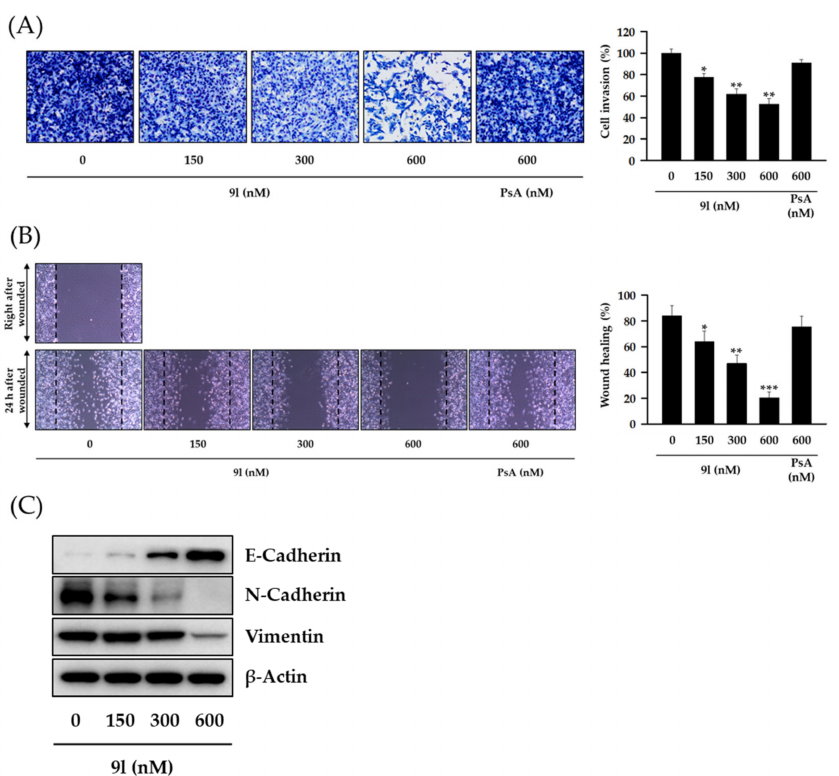
Figure 6. The inhibitory effects of 9l on cell invasion and migration via EMT gene regulation in TNBC cells. ( A ) MDA-MB-231 cells were pretreated with 9l or PsA at the indicated concentrations for 24 h, reseeded into the upper chambers of Transwell inserts, and incubated for 24 h. Cells invading the lower chambers were fixed, stained, imaged ( left ), and counted ( right ). * p < 0.05 and ** p < 0.01 values indicated statistically significant differences relative to the vehicle-treated control group. ( B ) Monolayers of MDA-MB-231 cells were mechanically scratched and treated with 9l or PsA for 24 h. Representative light microscopy images of wound closure are shown ( left ). Wound areas were quantified using Image J ( right ). * p < 0.05, ** p < 0.01 and *** p < 0.001 values indicated statistically significant differences relative to the vehicle-treated control group. ( C ) The protein expression levels of E-cadherin, N-cadherin, and vimentin in MDA-MB-231 cells treated with 9l for 24 h were determined via western blotting. β -Actin was used as an internal